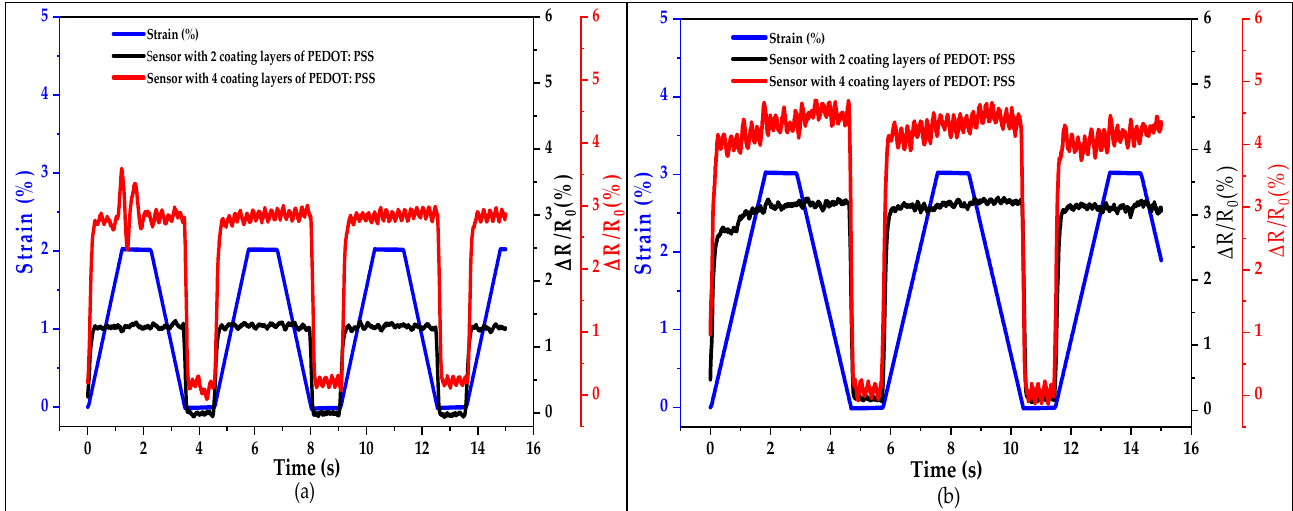
Figure 10. The ∆ R/R 0 versus time between 0 and 16 min under loading–unloading cycles for sensor yarns with two and four coated layers of PEDOT:PSS with strains of ( a ) 2% and ( b ) 3%.